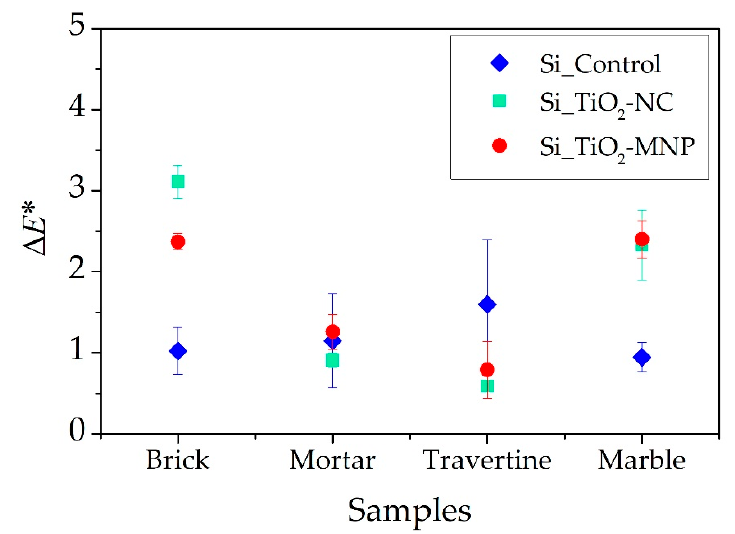
Figure 3. Color differences ∆ E * generated by the application of all coatings, with respect to the untreated specimen: Si_Control: coating without nanoparticles; Si_TiO 2 -NC: coating with TiO 2 nanoparticles and loaded silica nanocapsules; Si_TiO 2 -MNP: coating with TiO 2 nanoparticles and loaded silica mesoporous nanoparticles.